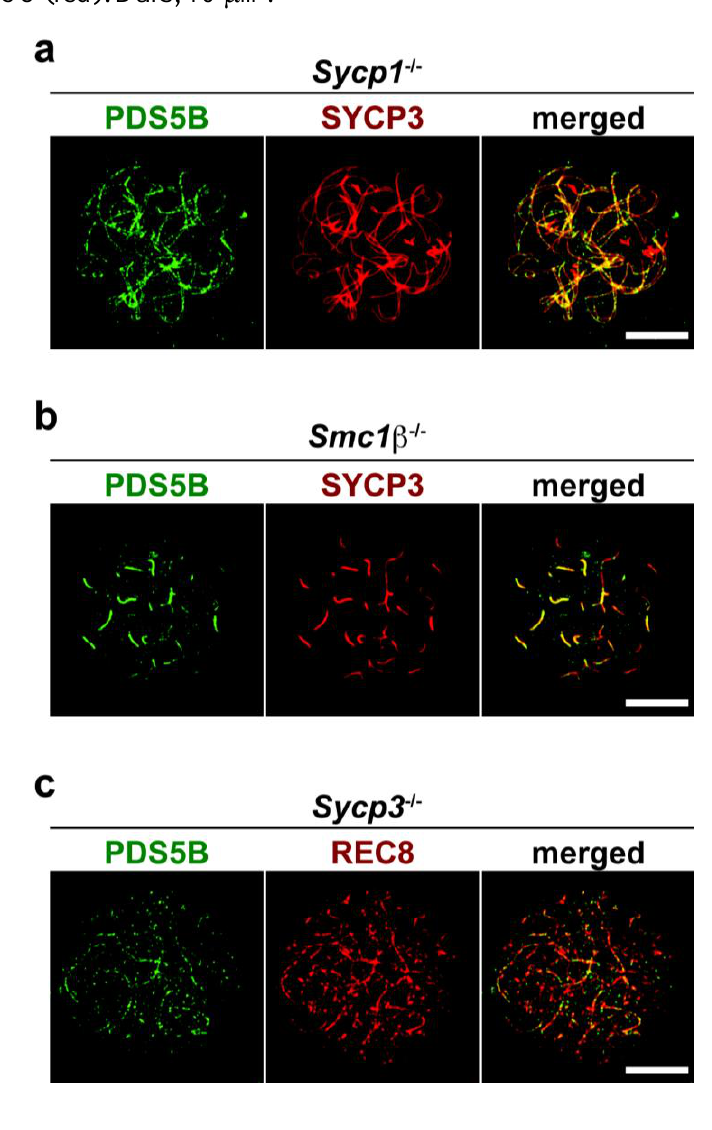
Figure 4. PDS5B localization in synaptonemal complex (SC) mutants. ( a ) Sycp1 -/- spermatocyte stained with antibodies against PDS5B (green) and SYCP3